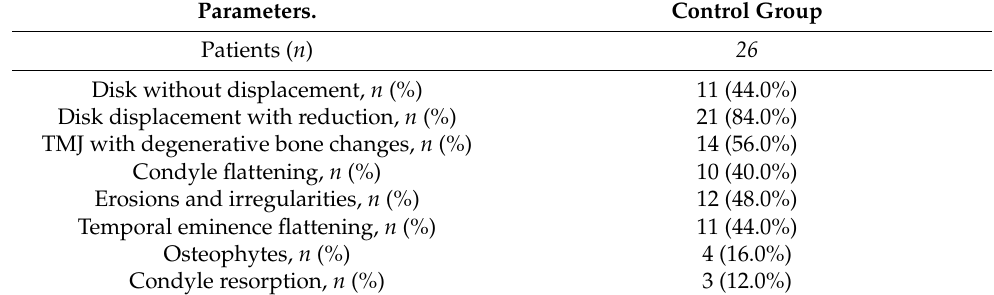
Table 5. Signs of TMJ dysfunction in the two groups. Parameters.